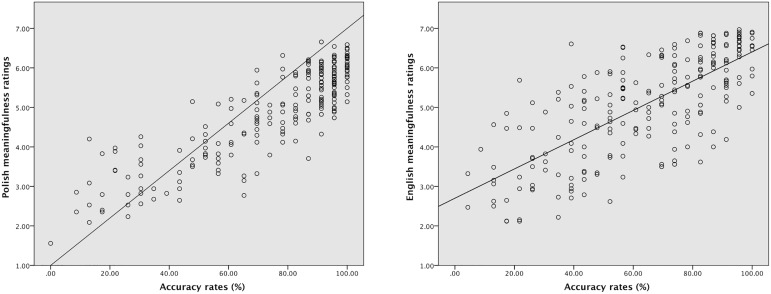
Scatterplots showing the correlations between meaningfulness ratings (y-axis) and accuracy rates (x-axis) for word dyads in Polish (left-hand side) and English (right-hand side).